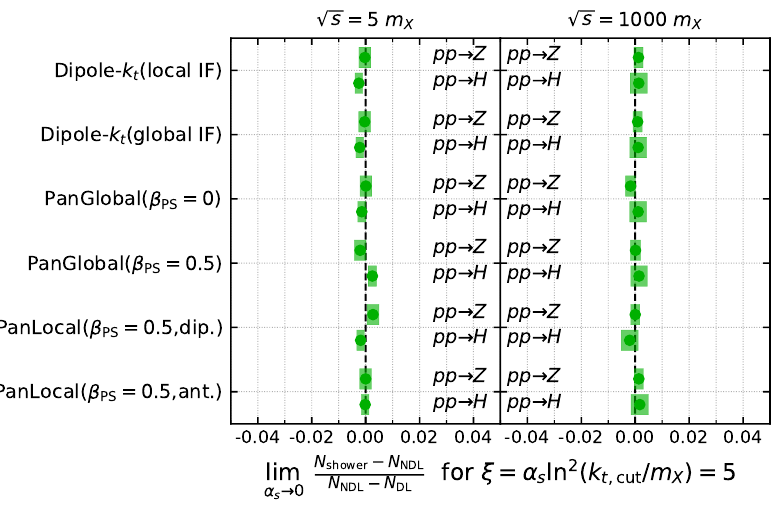
Figure 8. Extrapolation of N shower − N NDL to α s = 0 at a fixed value of ξ = α s L 2 for all showers, N NDL − N DL √ √ two different energies ( s = 5 m X , left, and s = 1000 m X , right), and the two processes under study, i.e. pp → Z and pp → H